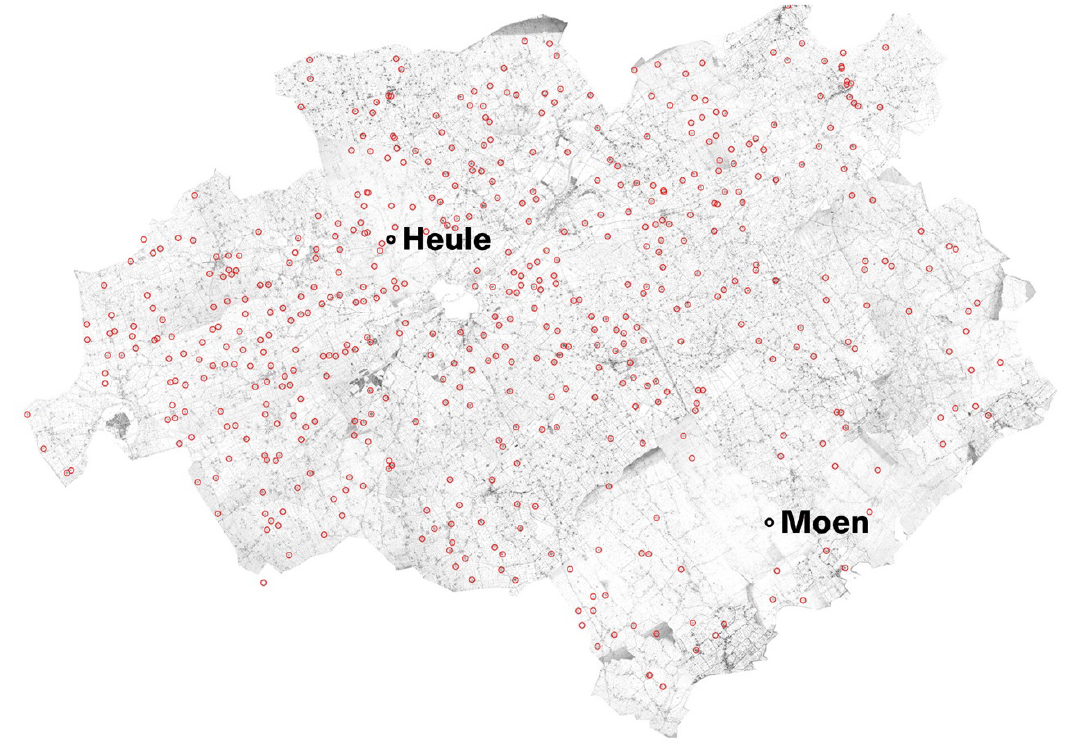
Figure 3. By the nineteenth century, hundreds of moated farmsteads in the region around Kortrijk formed a dense network. Source: Courtesy of E. Falomo, J. Hallaj, and E. Froelich (personal communication, 16 December